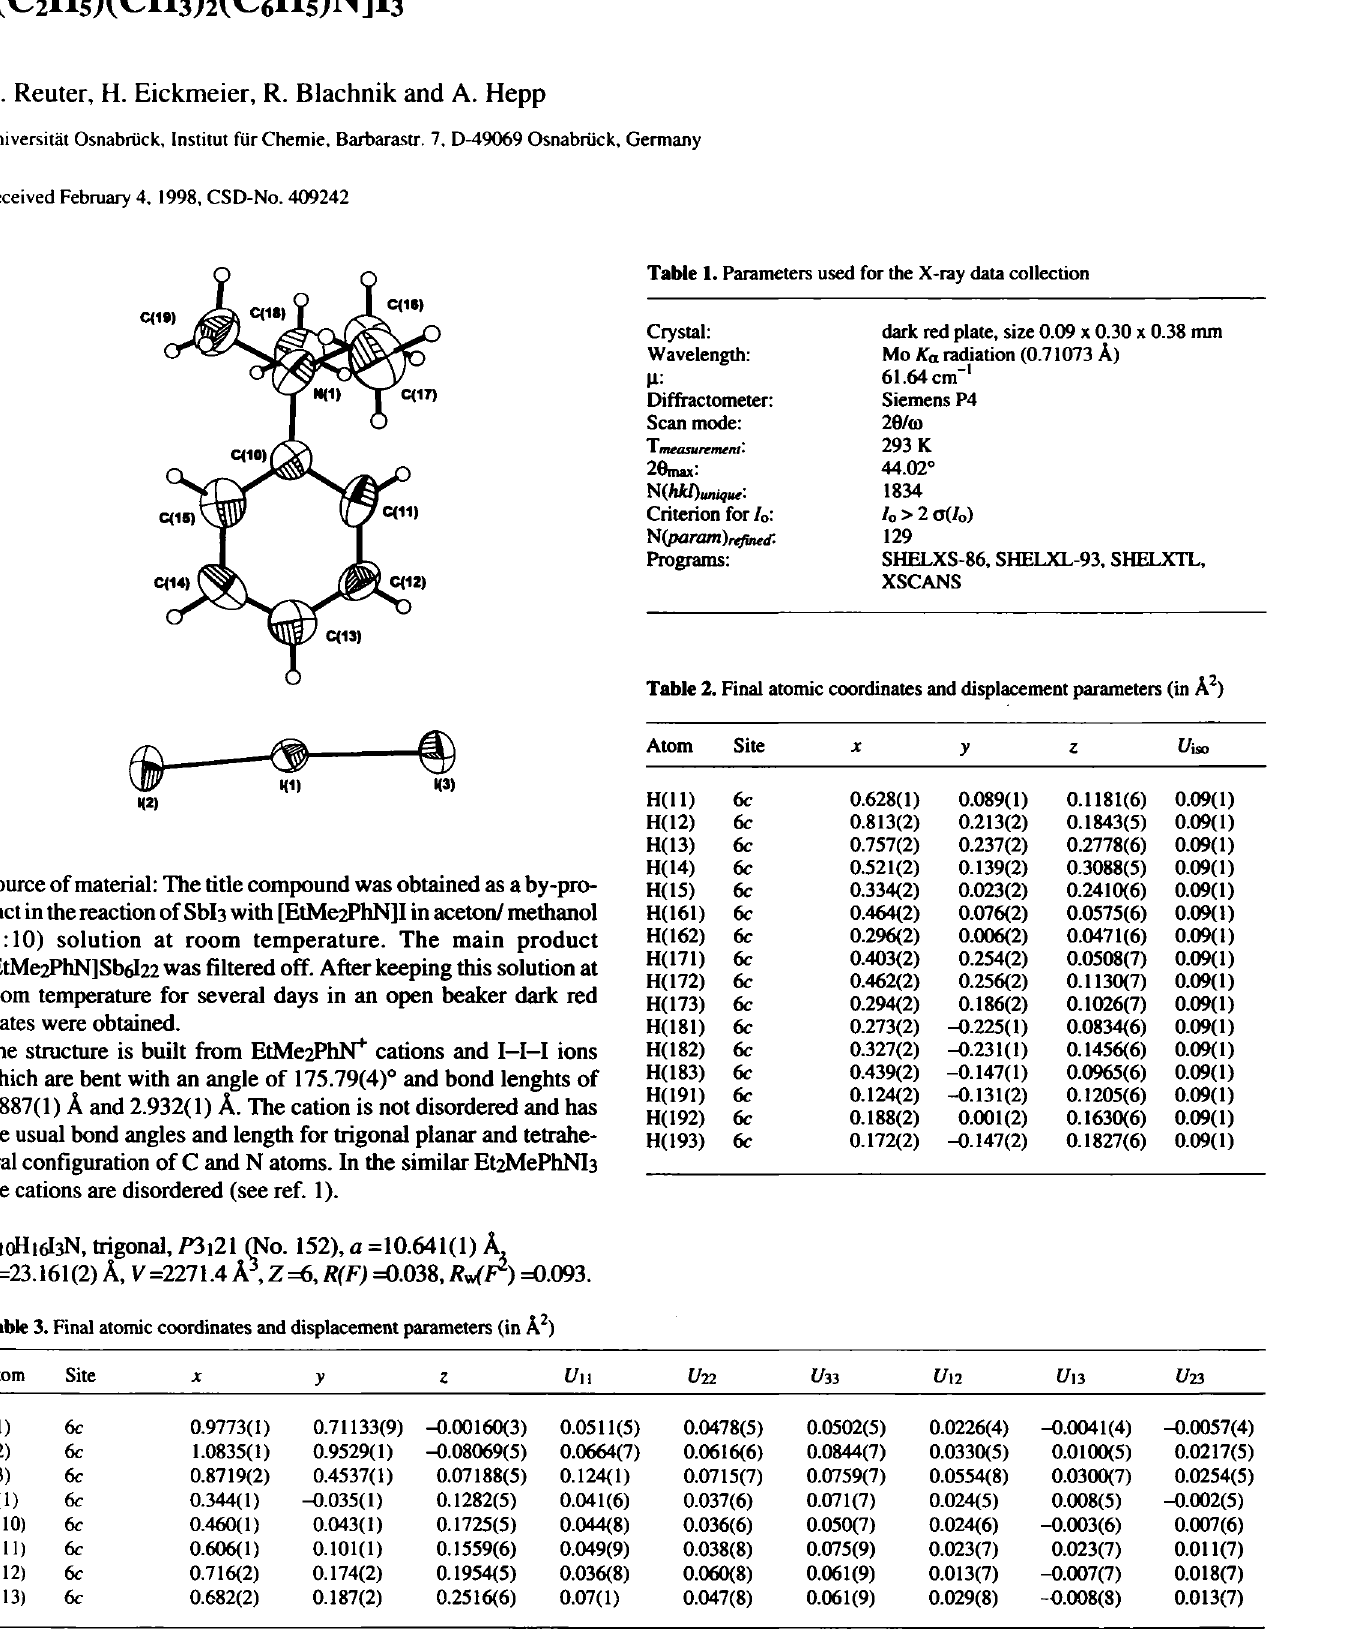
Table 1. Parameters used for the X-ray data collection